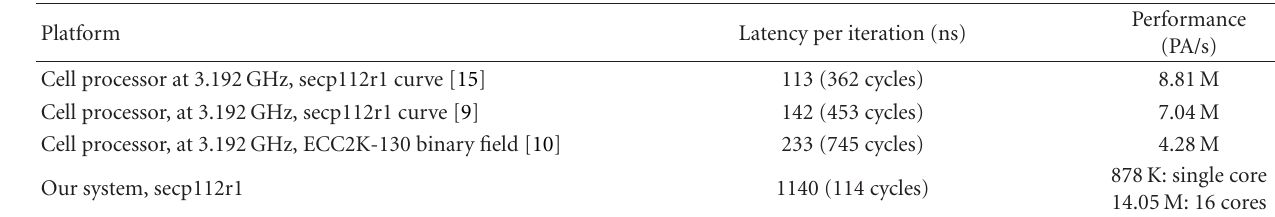
Table 3: Comparison with software ECDLP implementations.